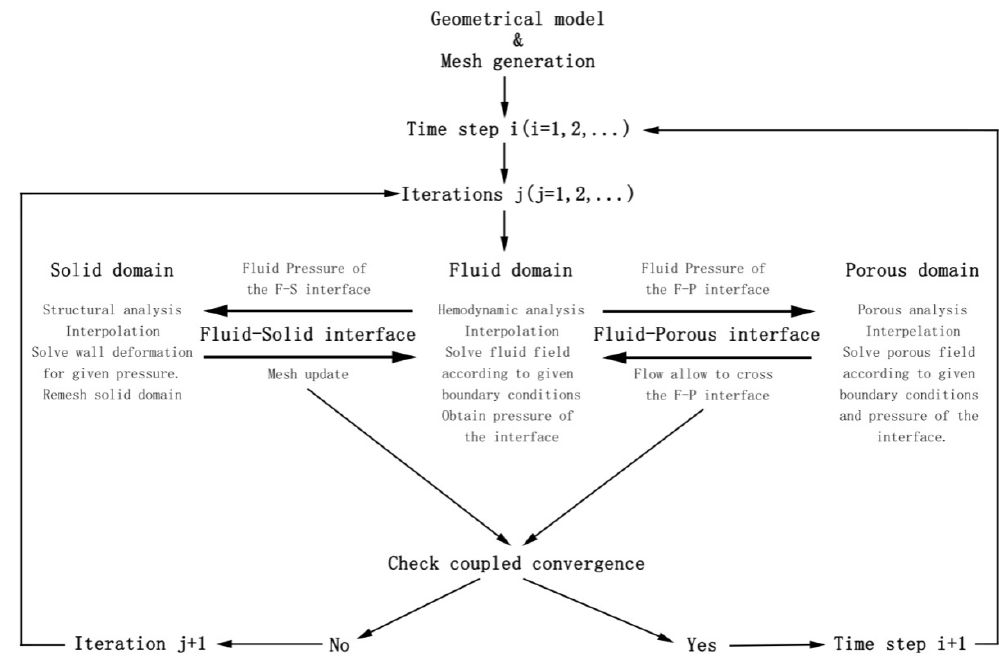
Figure 2. Computational methodology.